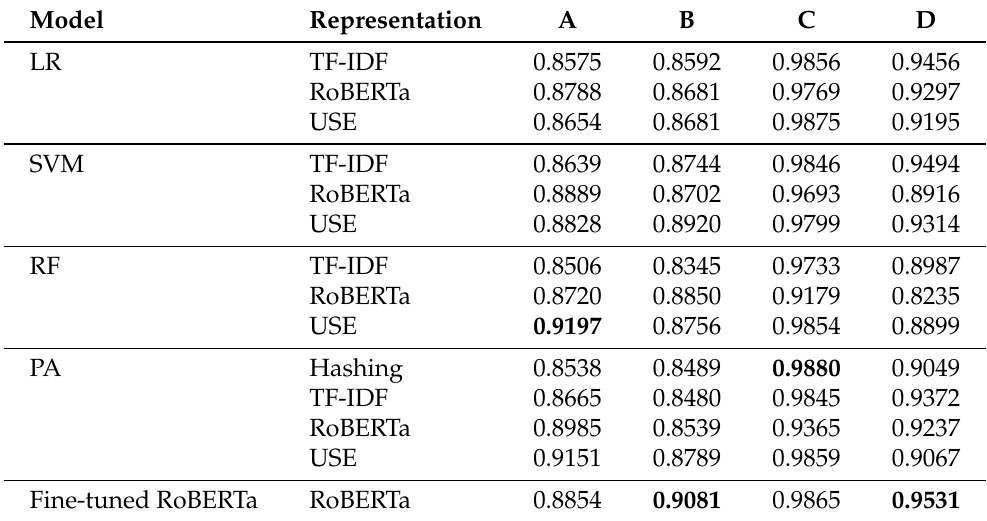
Table 4. Classification performance of the models trained on all labeled examples excluding the test set. Best score for each dataset is shown in bold. A–D correspond to the four datasets we used to conduct the experiments, which are described in Table 2. TF-IDF representation is calculated on the whole training set while the PA model is trained in the incremental learning